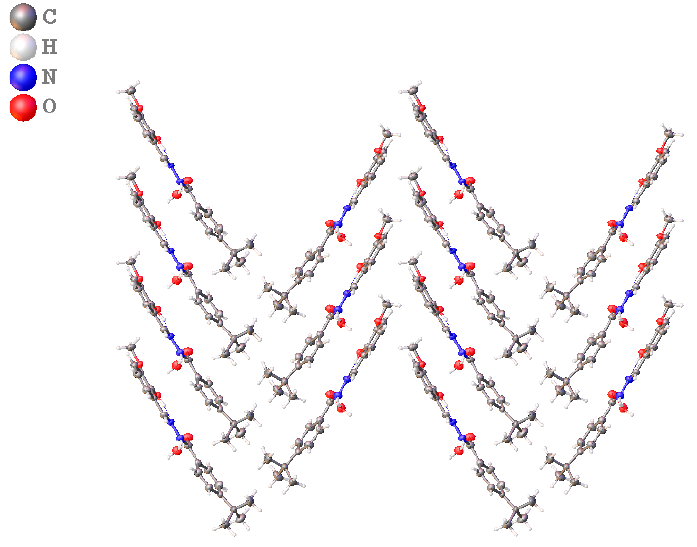
Figure 2. Crystal packing diagram of 4-(t-Bu)- N (cid:48) -(2-hydroxy-3-methoxybenzylidene)benzohydrazide ( 5 ). Table 2. Crystal and refinement data of complexes 5 and 14 .